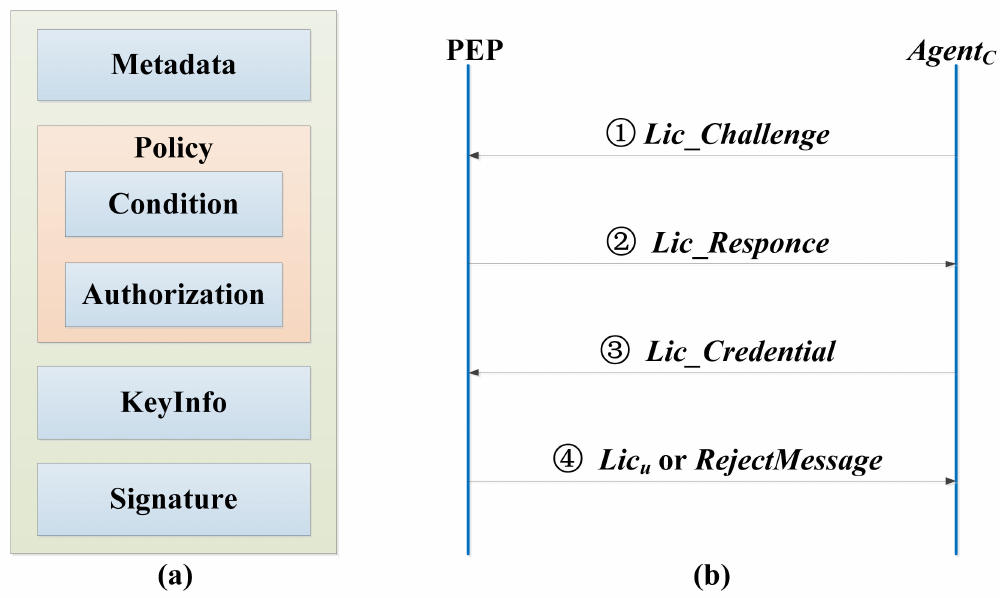
Figure 2. The license information structure and license negotiation interaction protocol. ( a ) License information structure; ( b ) license negotiation interaction